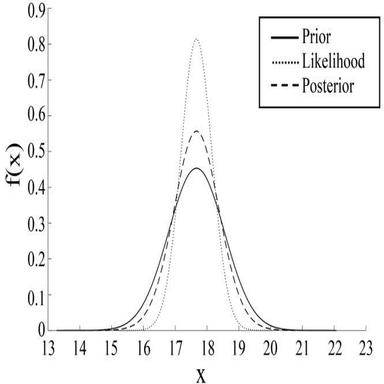
Prior and posterior probability density functions after Bayesian inference (arch flange thickness).